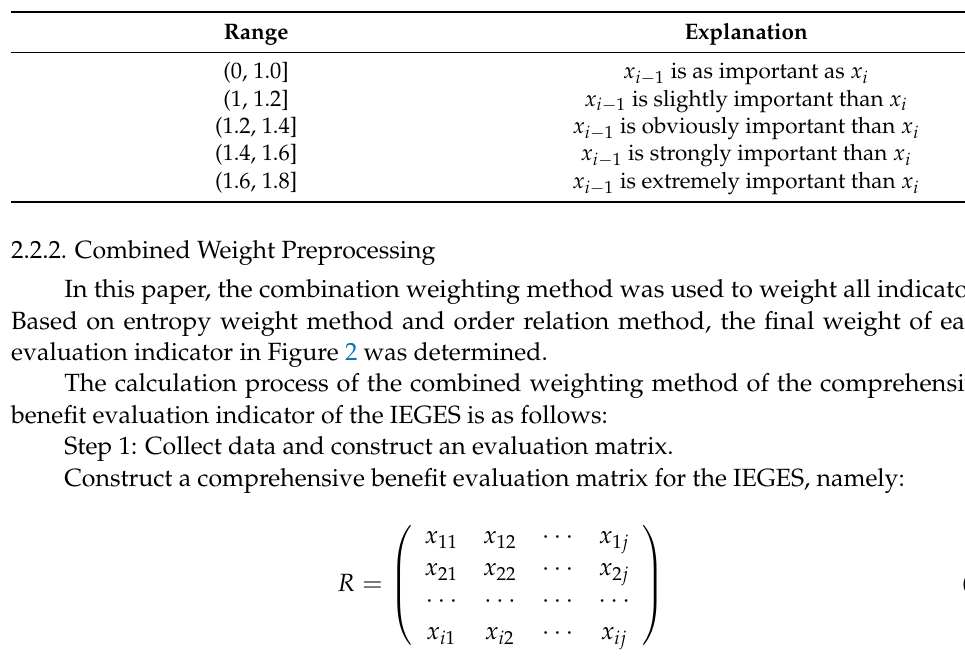
Table 2. Principles of p i